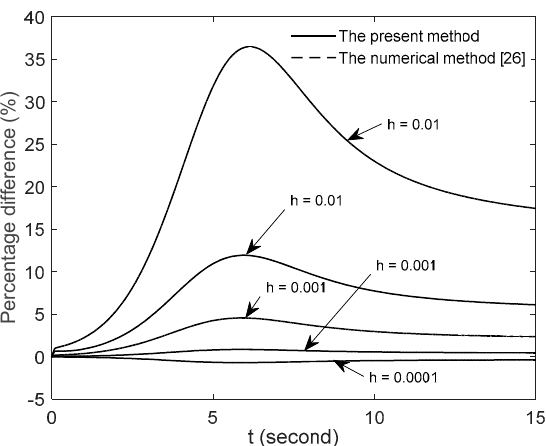
Figure 8. Percentage difference of x 1 obtained by the present method and the numerical method [26] comparing to the numerical method [26] with h = 0.0001.